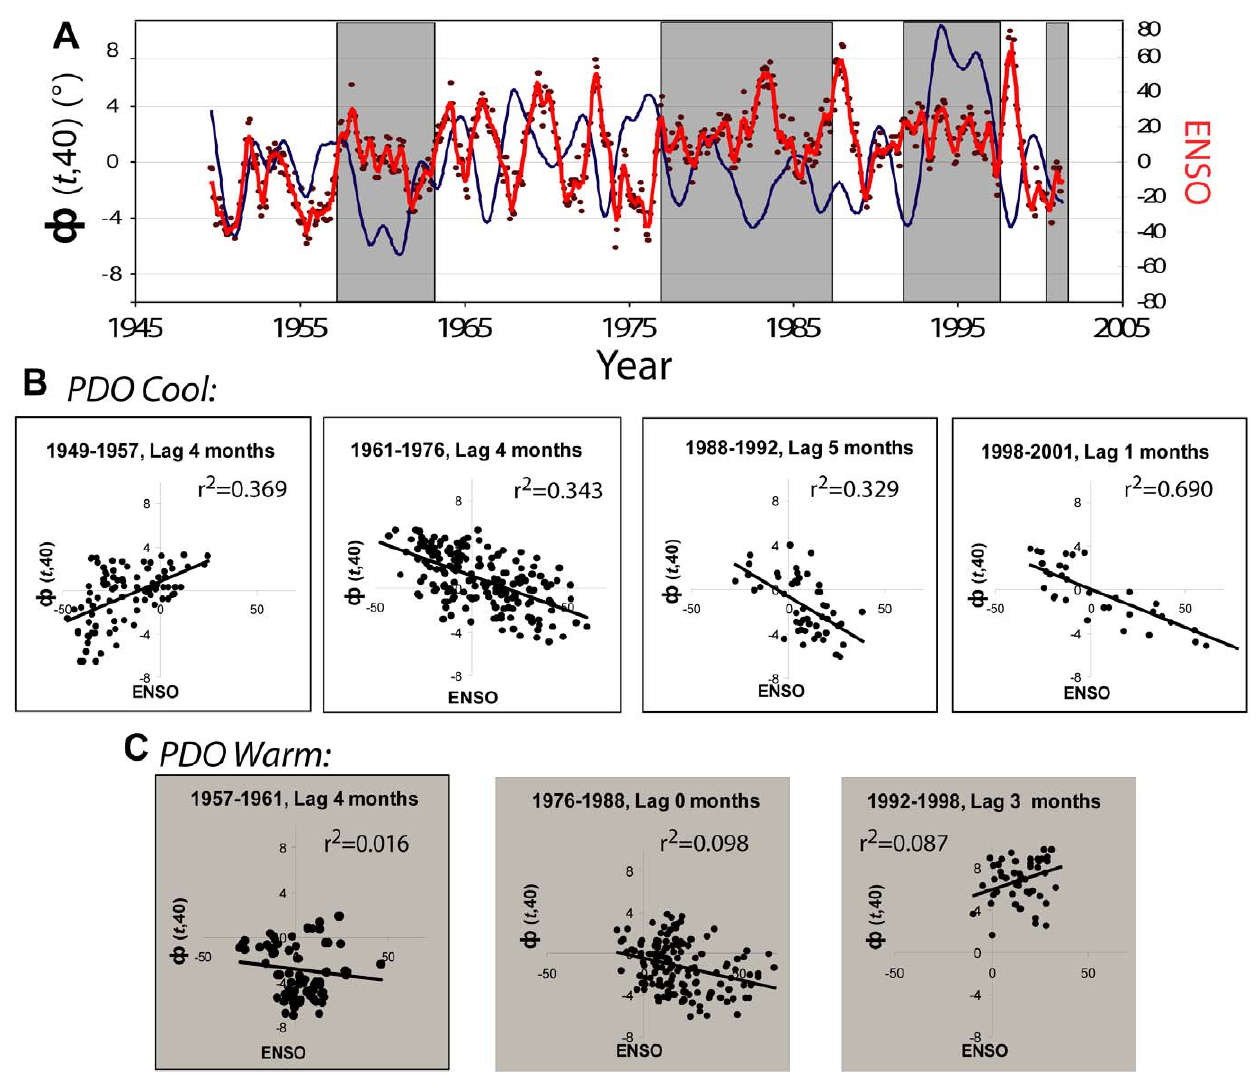
Figure 4. The temporal relationships and correlation structures of W ( t , n ) and the Global-SST ENSO index across the history of the PDO index from 1946 since 1946. (A) Plot of monthly W ( t ,40) time series (Blue) with the monthly Global-SST ENSO index (Red) from 1946–2004. The Global-SST ENSO index captures the low-frequency components of other, location specific ENSO indices. The data were continuous from January 1946 to December 2003. Global-SST ENSO is presented as raw, unfiltered values (points) and smoothed to produce similar high frequency contributions to W ( t ,40) (line) (see Methods). The periods 1957–1964, 1976–1988 and 1992–1998 are PDO ‘‘warm’’ phases and are indicated in gray, the intervals are PDO ‘‘cool’’ periods. (B and C) Plots of the Global-SST ENSO index plotted against W ( t ,40). Data were pre-whitened to reduce autocorrelation for analysis. Cross-correlation coefficients of determination (displayed) were estimated for the entire periods indicated. Data are plotted at the lag that produced the greatest cross-correlation coefficient magnitude to convey the strength of the relationship. The mean cross- correlation coefficient ( r ) for the PDO cool periods (B) was 0.67 at an average lag of 3. 5 months with ENSO leading W ( t ,40).